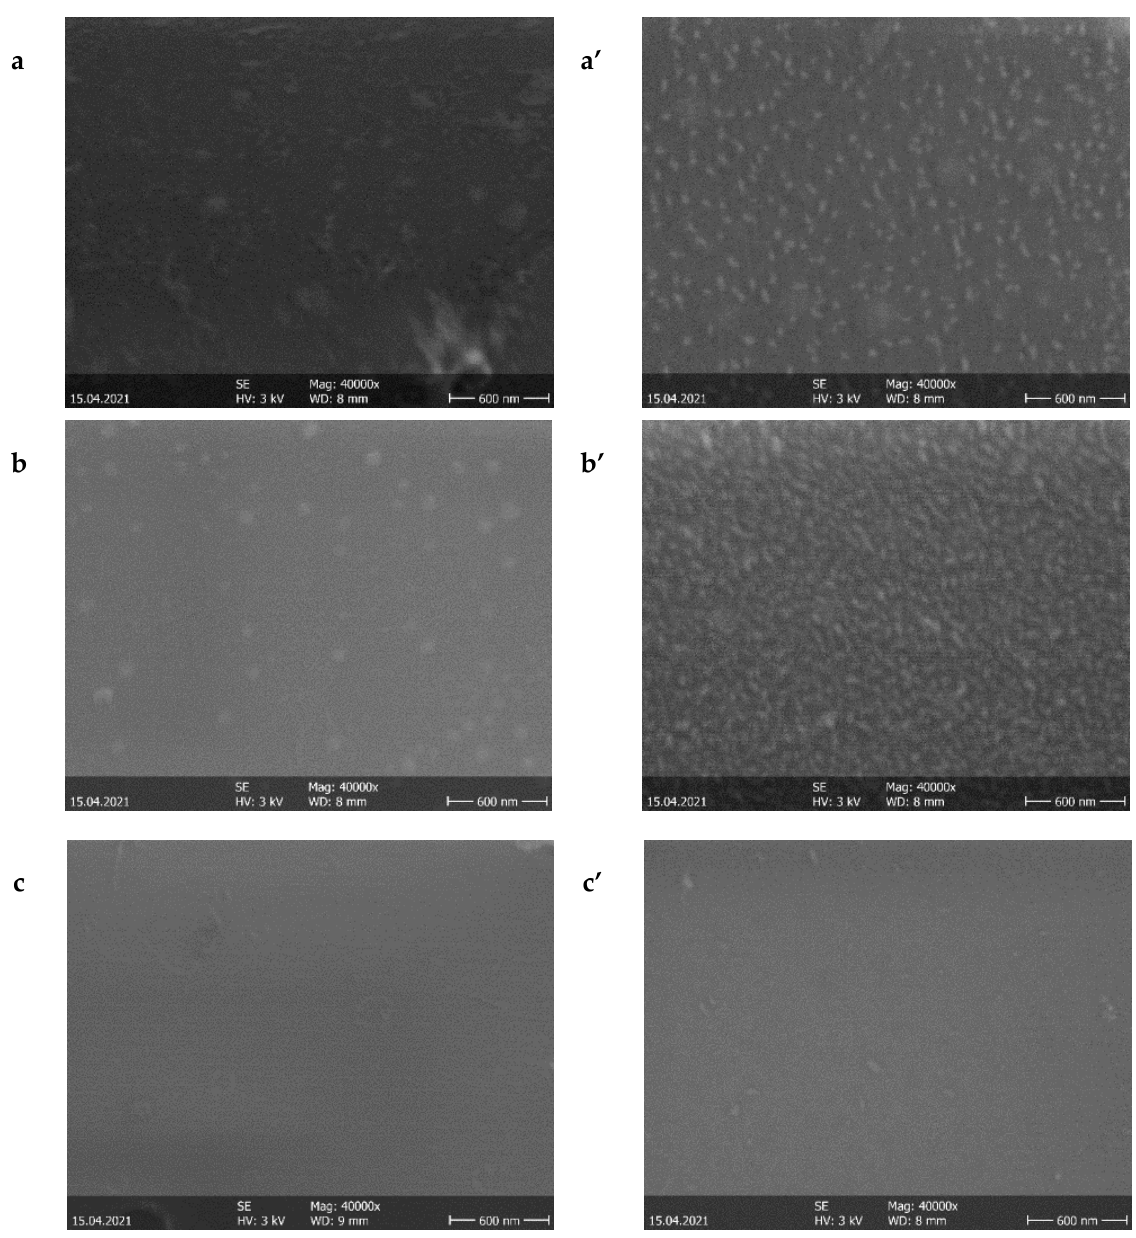
Figure 1. SEM micrographs of single oxide (bottom) layers: ( a ) TiO 2 , ( b ) TiO 2 :Nb and ( c ) NiO; and SEM micrographs of the top oxide layers of oxide/Ag/oxide multilayer structures: ( a’ ) TiO 2 , ( b’ ) TiO 2 :Nb and ( c’ ) NiO.